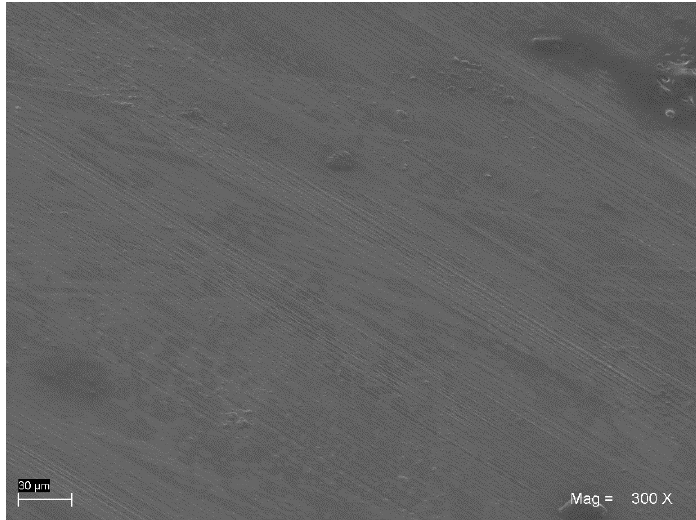
Figure 10. Group 6. After 50 steam autoclave cycles, no areas of corrosion were observed.